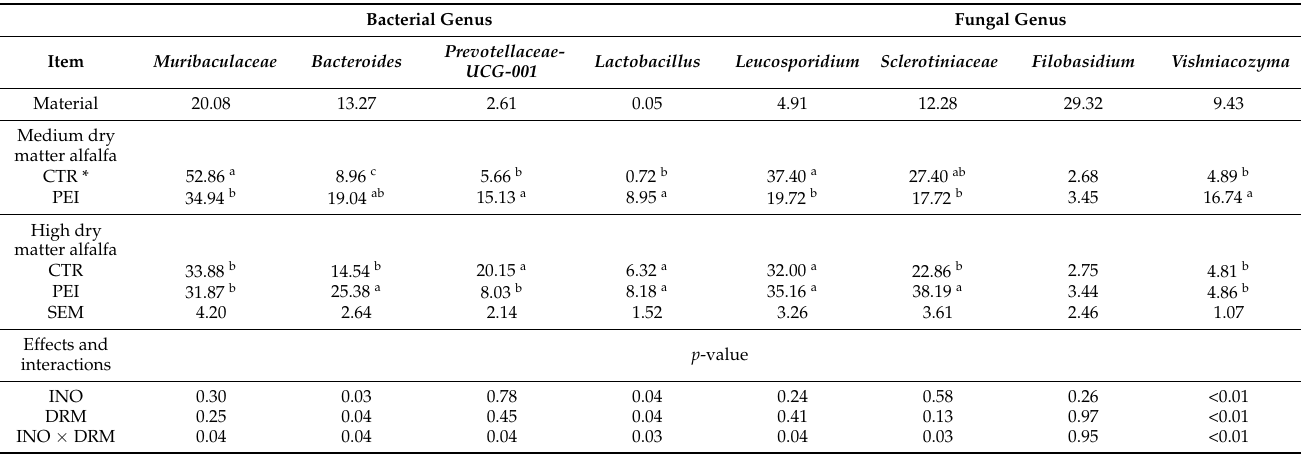
Table 6. Relative abundance (%) of material, bacterial genus and fungal genus in alfalfa silages ensiled for 60 d, as analyzed by the sequencing of the V4–V5 region of the 16S rRNA, for bacteria, and ITS1, for fungi, using the Illumina MiSeq